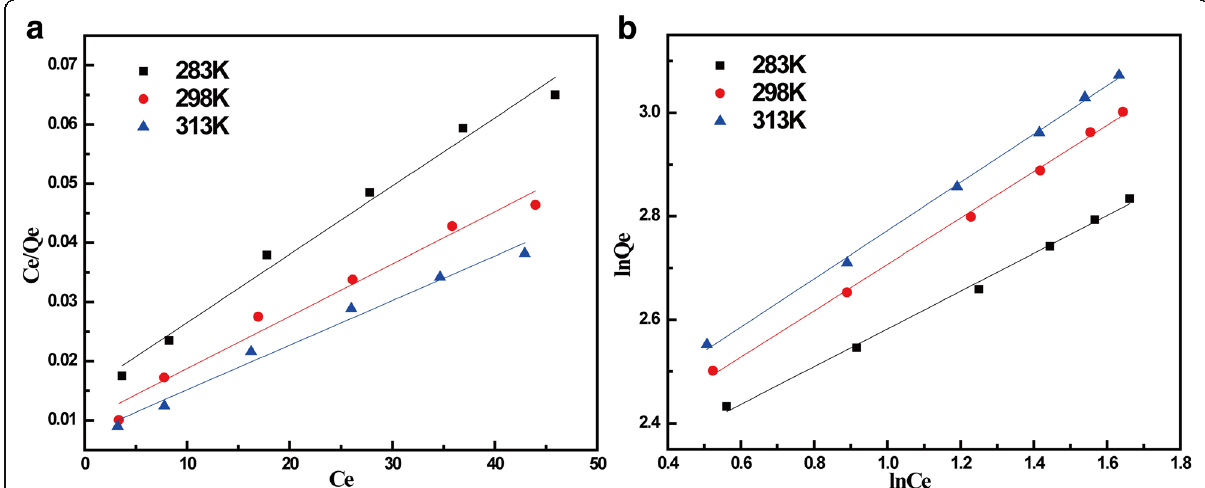
Fig. 5 TC adsorption isotherms of MnFe 2 O 4 /rGO nanocomposite. Adsorption isotherms fitted with ( a ) Langmuir model and ( b ) Freundlich isotherm at 283, 298, and 313 K,